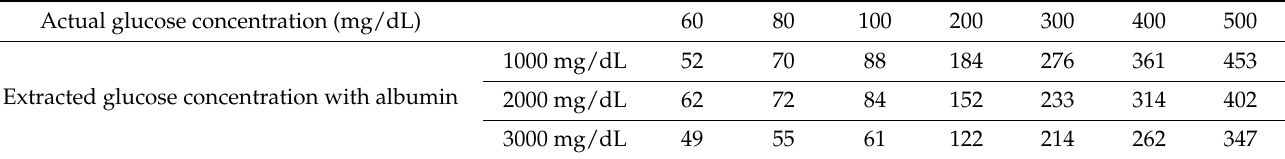
Table 4. Extraction values of glucose concentration for tissue phantom solutions with different albumin concentrations. Actual glucose concentration (mg/dL) Extracted glucose concentration with